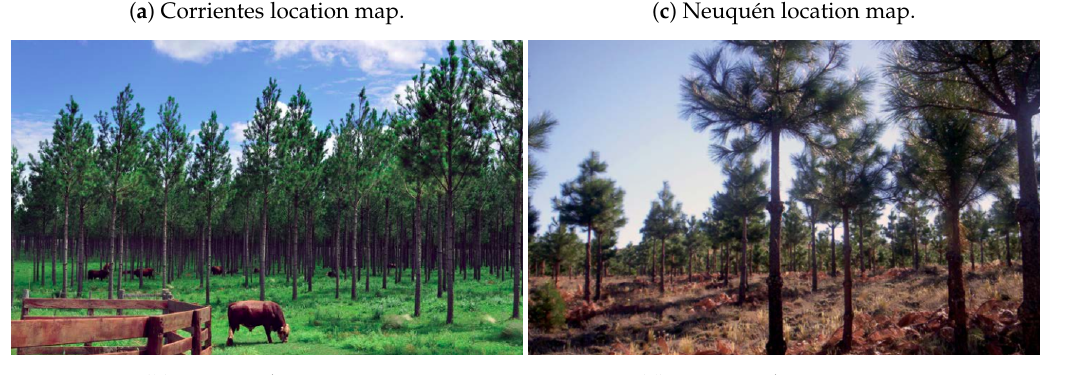
Figure 2. Study-areas in Corrientes and Neuquén provinces,